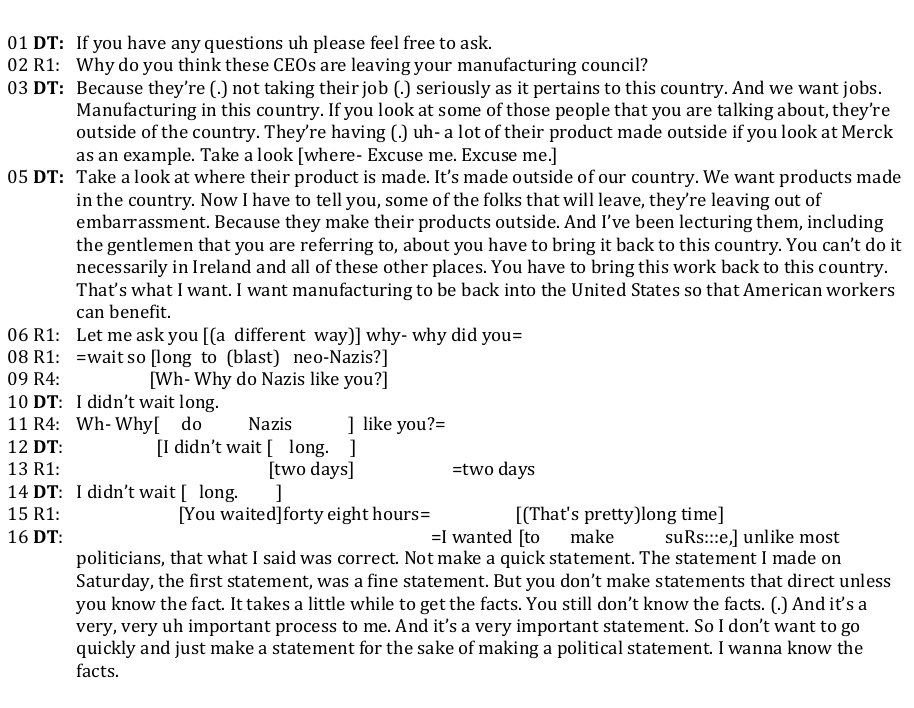
Figure 4. Transcript excerpt 01–16.